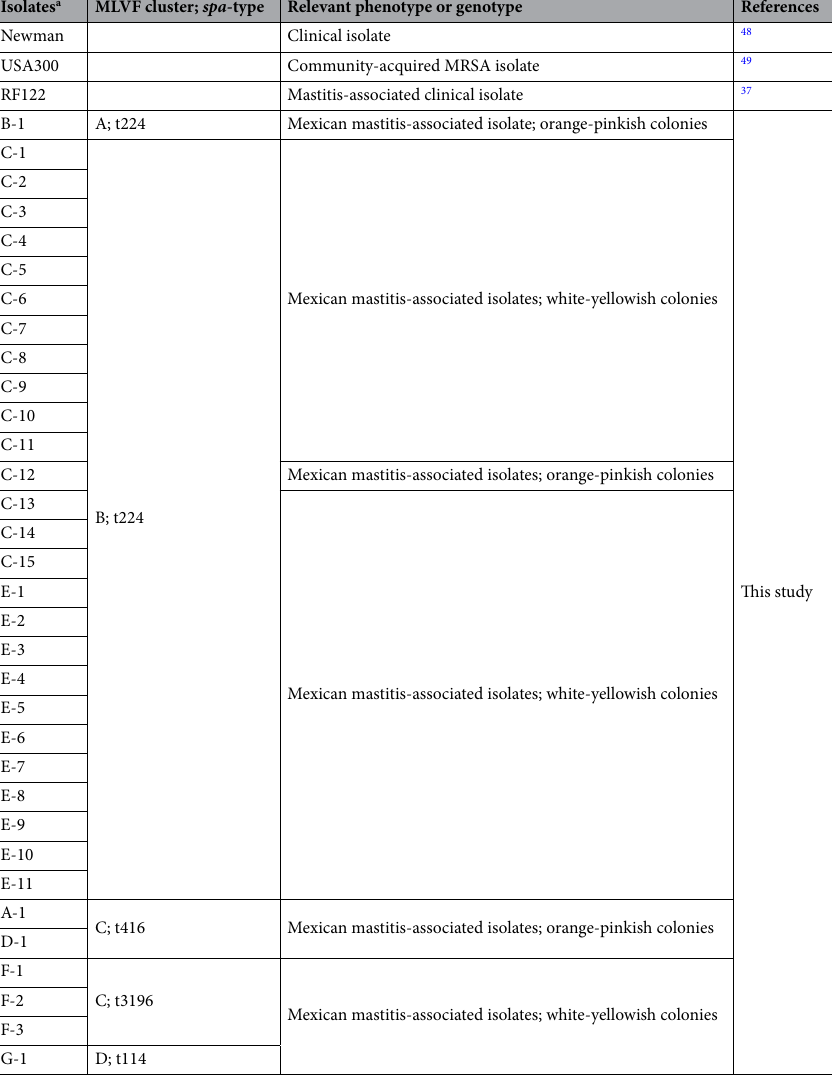
Table 1. Bacterial strains used in this study. a The letters A to G in the names of the isolates refer to the different farms from which they were